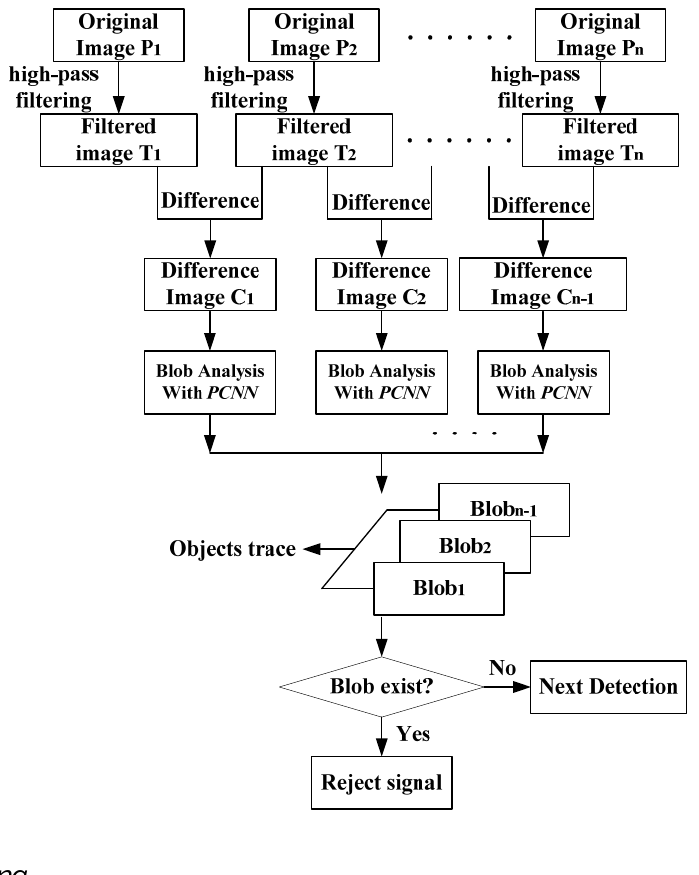
Figure 9. Foreign substances detection